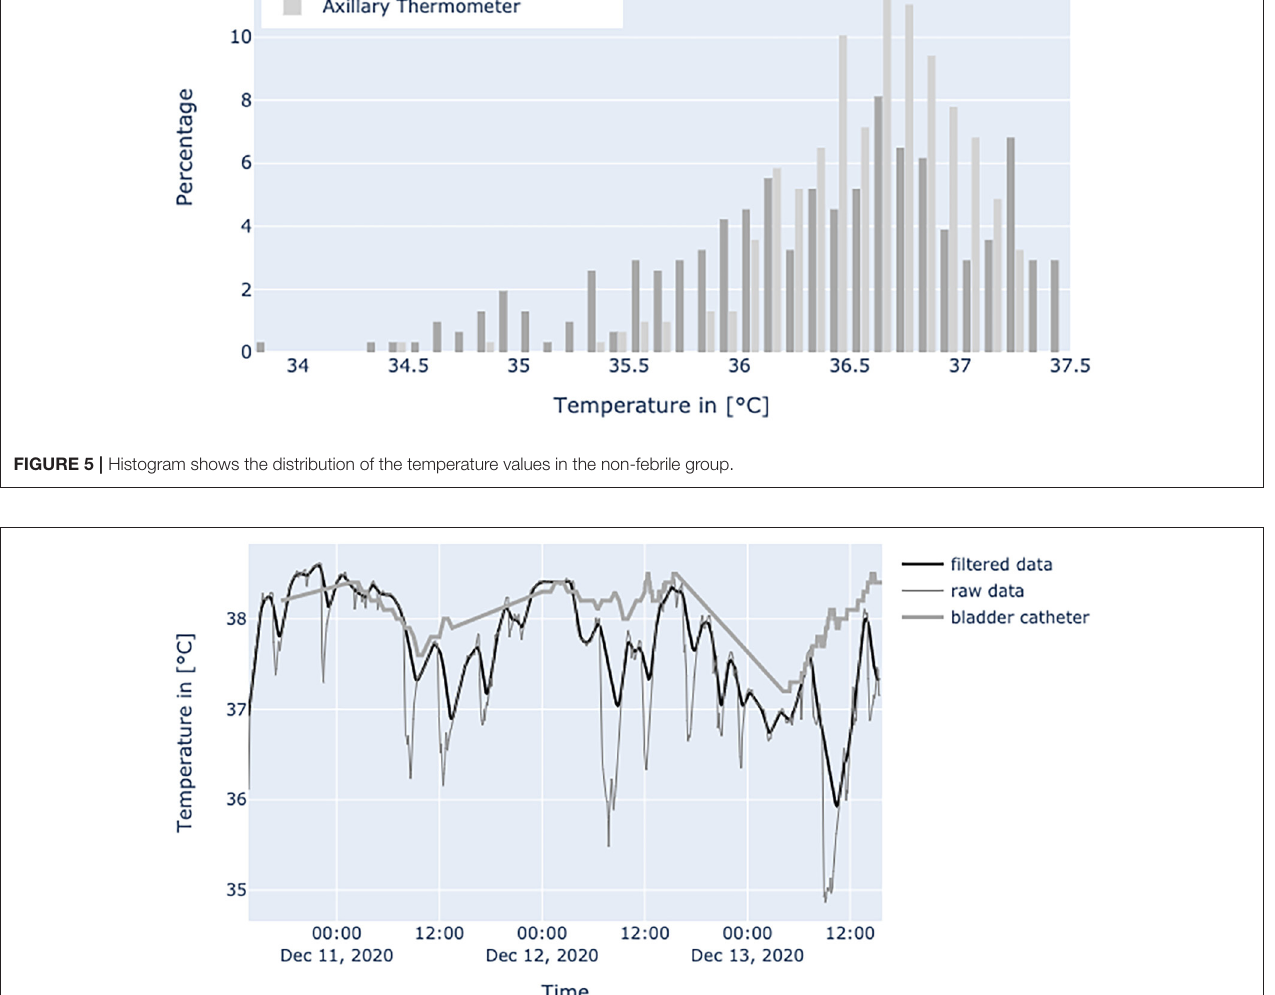
FIGURE 6 | Diagram shows data from a female patient, 79 years old with nosocomial pneumonia. Even with lots of environmental factors distorting peripheral temperature values the trend of core temperature and fever can be estimated